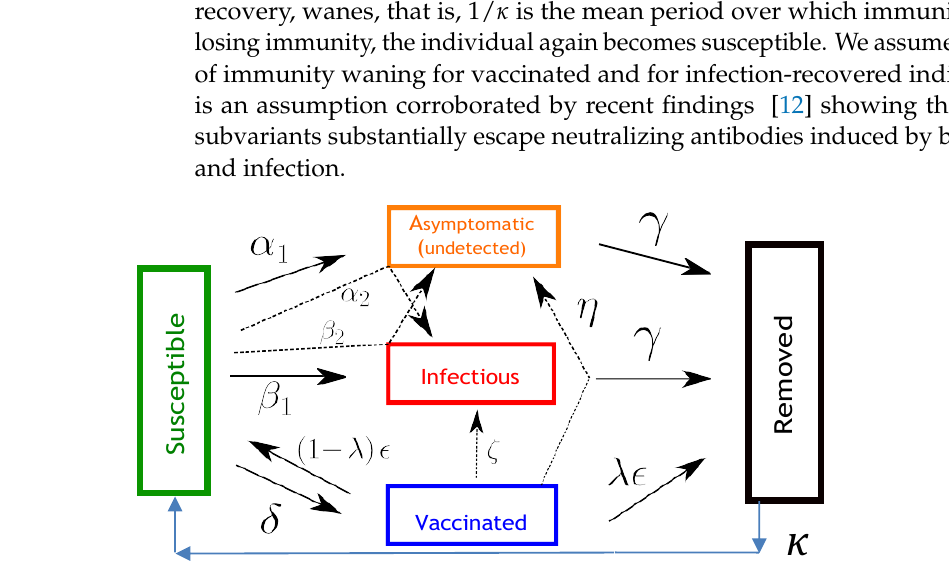
Figure 1. Illustration of the compartments of the SAIVR model with waning immunity ( κ > 0) and their interdependencies denoted by incoming and outgoing arrows and relevant flow